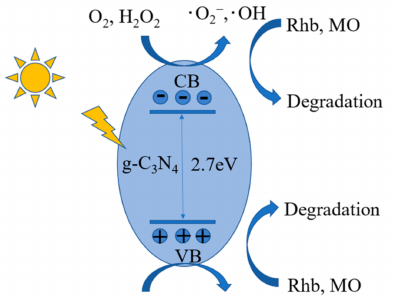
Figure 12. Schematic diagram of the mechanism of synergistic